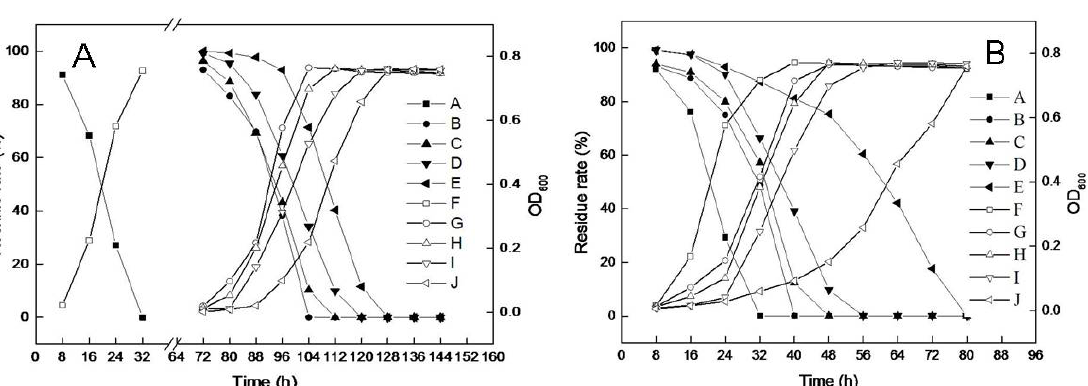
Figure 4. Effect of NaCl concentration on biomass and DBP biodegradation by strain